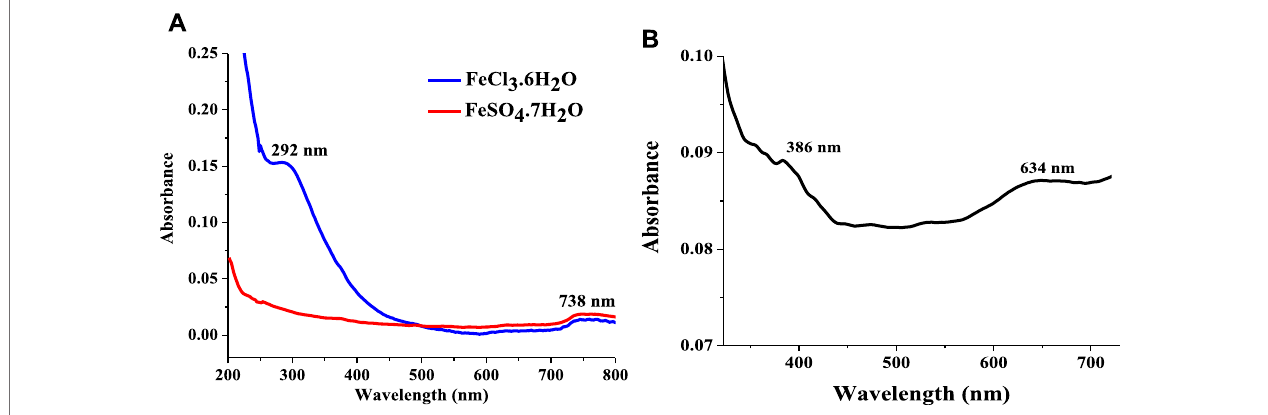
FIGURE 4 | SEM micrograph of Fe 3 O 4 nanoparticles at (A) low magni fi cation (×20,000) and (B) high magni fi cation (×100,000). (C) TEM micrograph of Fe 3 O 4 NPs and (D) Size distribution chart of Fe 3 O 4 NPs in the TEM image.